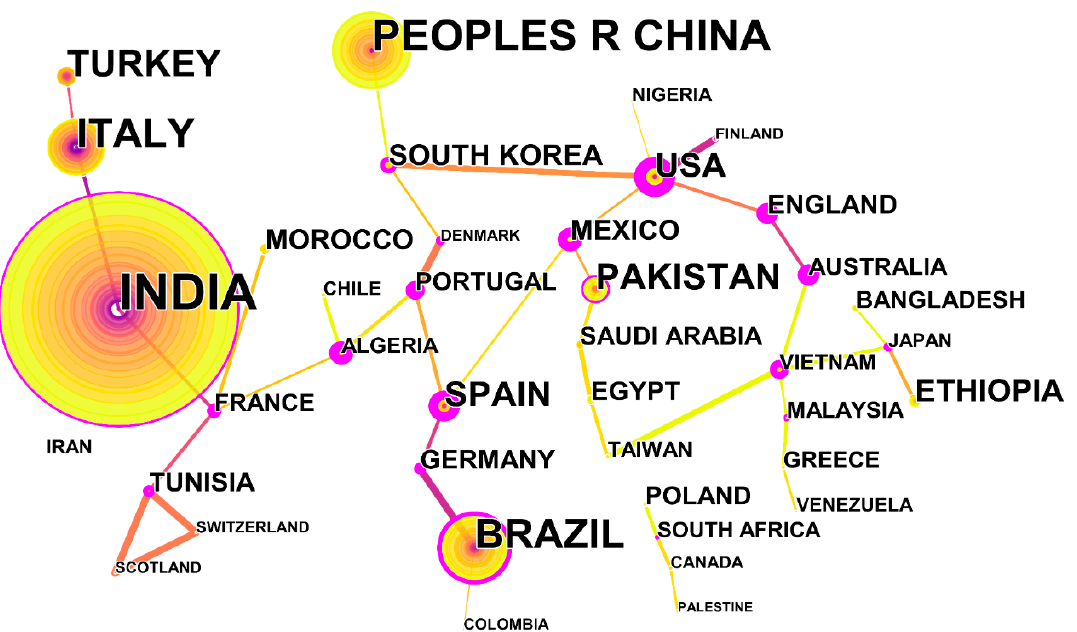
Figure 3. Countries performing tannery wastewater research. Tannery wastewater research is being pursued by governments across the globe, as indicated. In comparison to other countries and regions, India is the most productive country. Cooperative ties between countries and areas are depicted in Figure 3 by the dotted lines. Italy and India have a long history of cooperation. Although showing a low level of cooperation among countries and regions, the weak connections between nodes suggest a future need for further